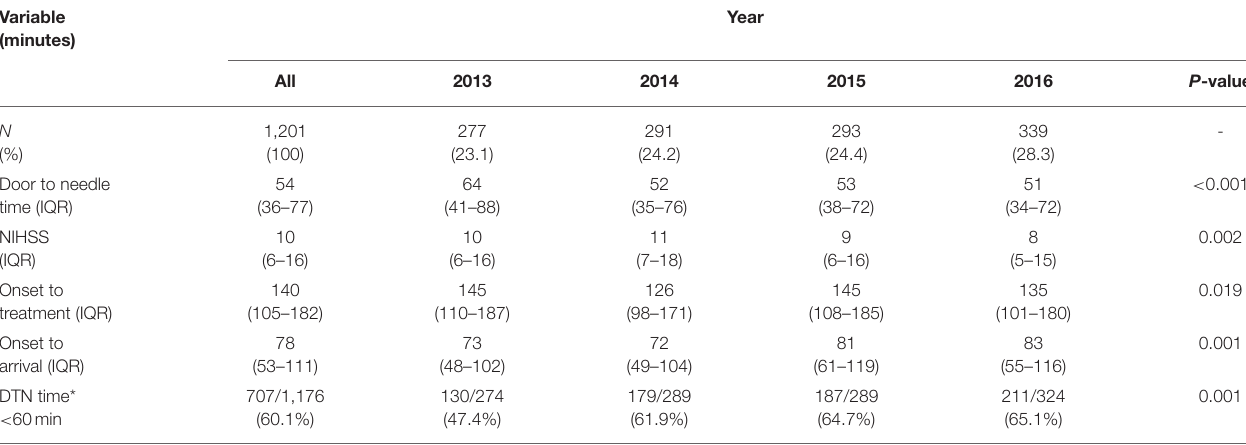
TABLE 2 | Median annualized processing delays and stroke severity.